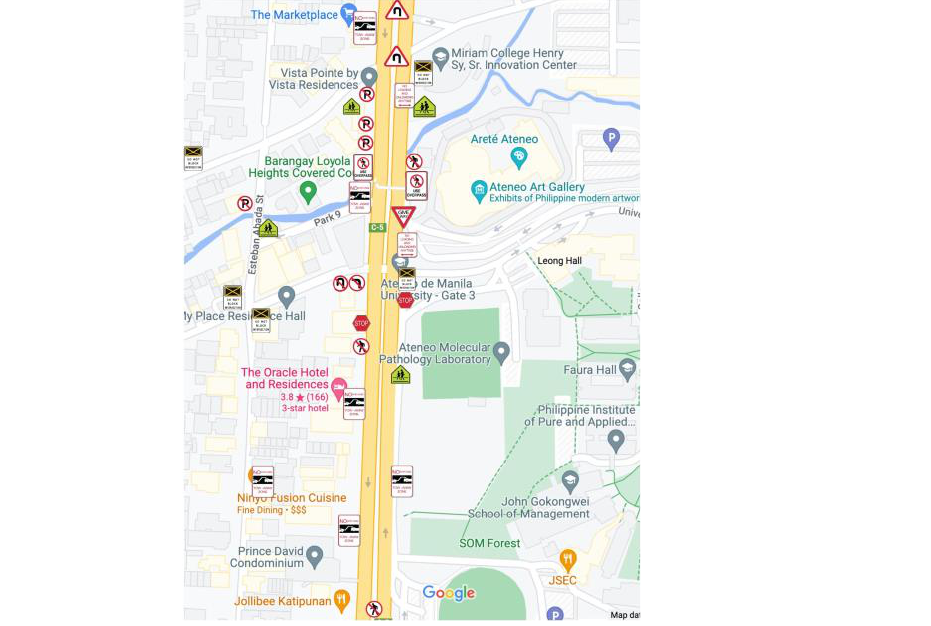
Figure 2. Some of the traffic signs posted along C-5 road in Quezon City.